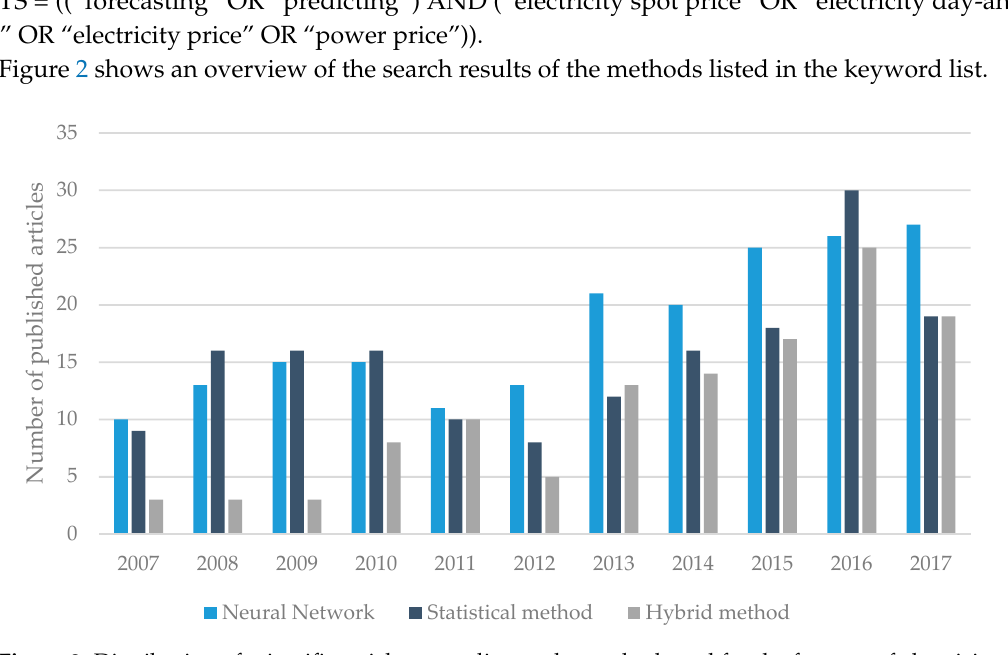
Figure 2. Distribution of scientific articles according to the method used for the forecast of electricity price, published from 2007 to 2017.